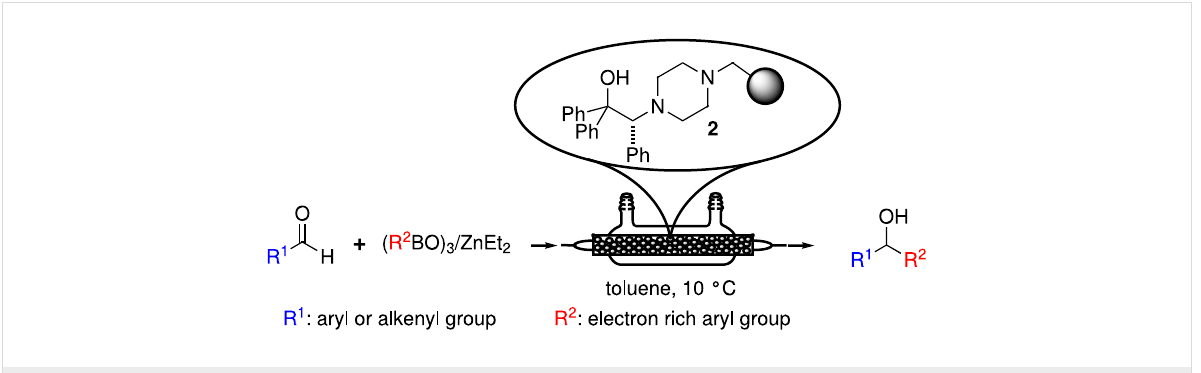
Scheme 5: Continuous flow enantioselective preparation of